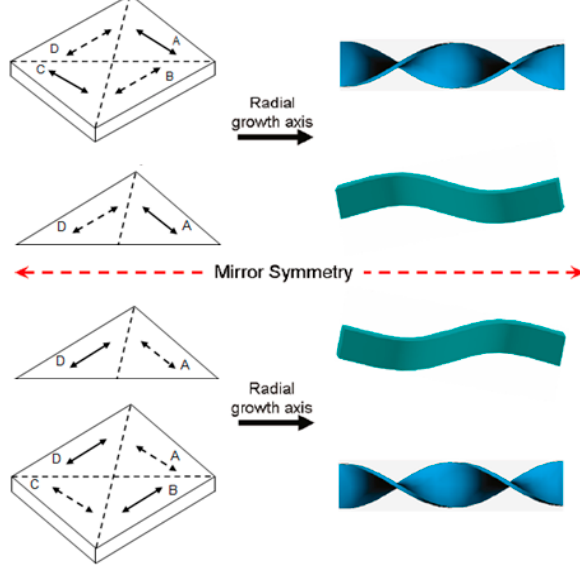
Figure 17. Effect of molecular chirality on the distribution of surface stresses and the corresponding chirality of lamellar curvature. The black solid and dashed arrows indicate the net tensile stress on the top and bottom surface of the lamella, respectively. Adapted with permission from Ref. [15]. Copyright (2010) American Chemical Society.